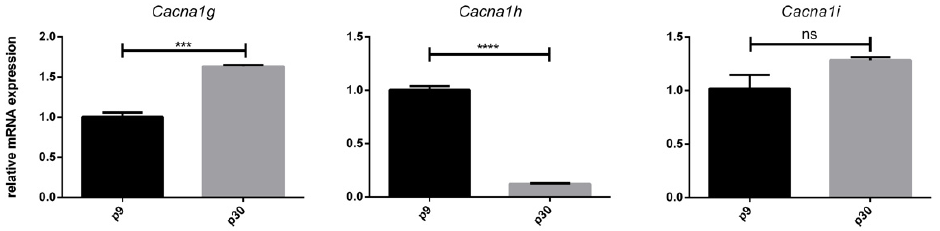
Figure 3. In vivo expression of Cacna1g , Cacna1h , and Cacna1i : Examination of the relative mRNA expression pattern of Cacna1g , Cacna1h , and Cacna1i in PCs was performed at p9 and p30 via qPCR of LMD samples. The values were normalized against the values of the PCs of p9, and Gapdh was the housekeeping gene. Note that 1,000,000 µ m 2 of enriched PCs from 20 different rat cerebella were collected. The analysis was performed with the help of the 2 − ∆∆ ct method. Significant differences were indicated by *** p < 0.001, **** p < 0.0001; ns = not significant.